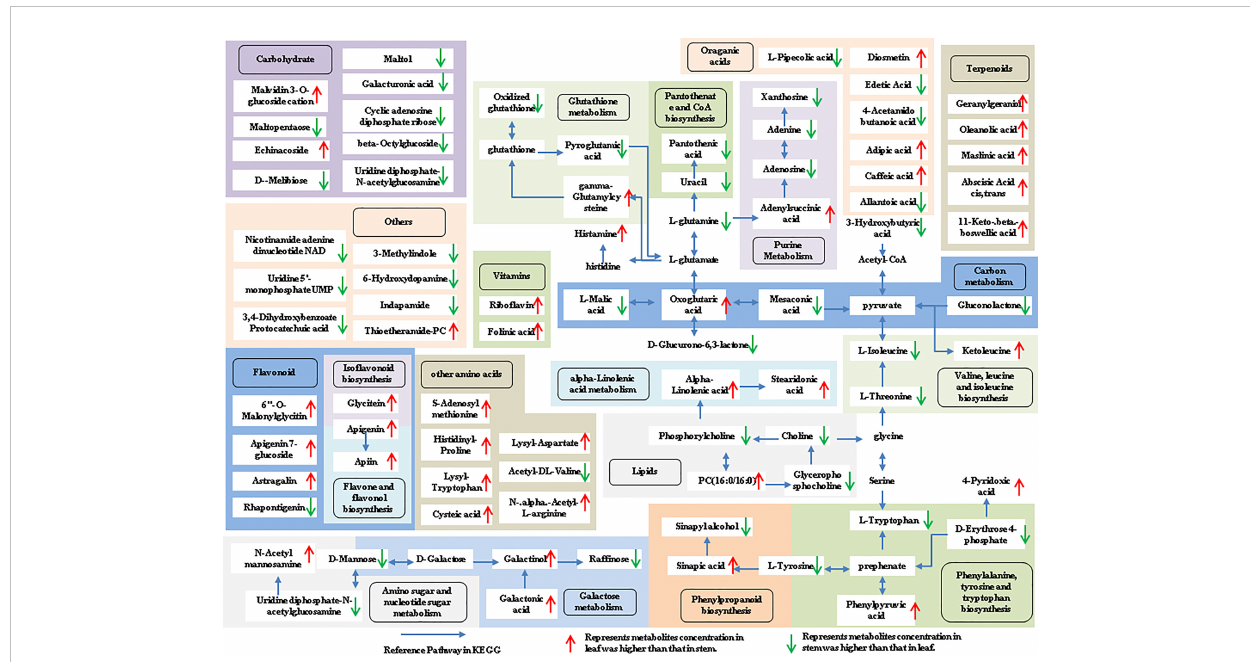
FIGURE 7 Metabolic pathways analysis in leaf-stem group of P. cablin . The 83 metabolites identi fi ed in leaf-stem group were mapped onto primary and secondary metabolism. The upward-pointing red arrows represent the value of |log2| (content leaf/stem) >1, which means the level of metabolites in leaf is higher than that in stem, the value of |log2|(content leaf/stem) <1 represents metabolites concentration in stem was higher than that in leaf, and represented by downward-pointing green arrows.